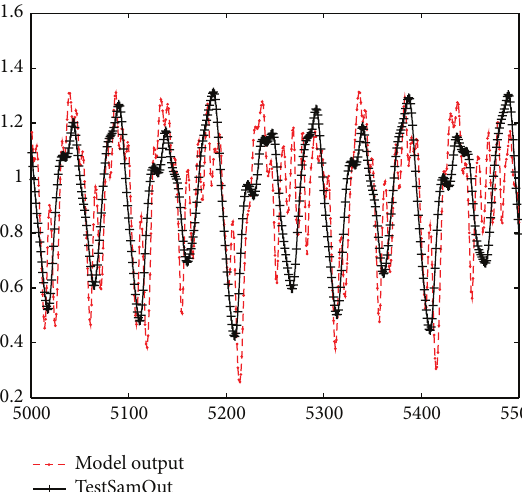
Figure 5: Fitting of Mackey-Glass chaotic time series, GDA.